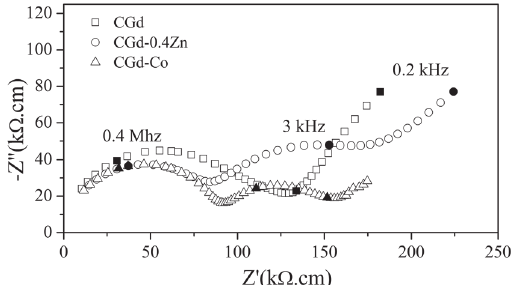
Figure 7: Impedance spectra, measured at 250 °C, of the samples sintered at 1200-1000 °C/10h.